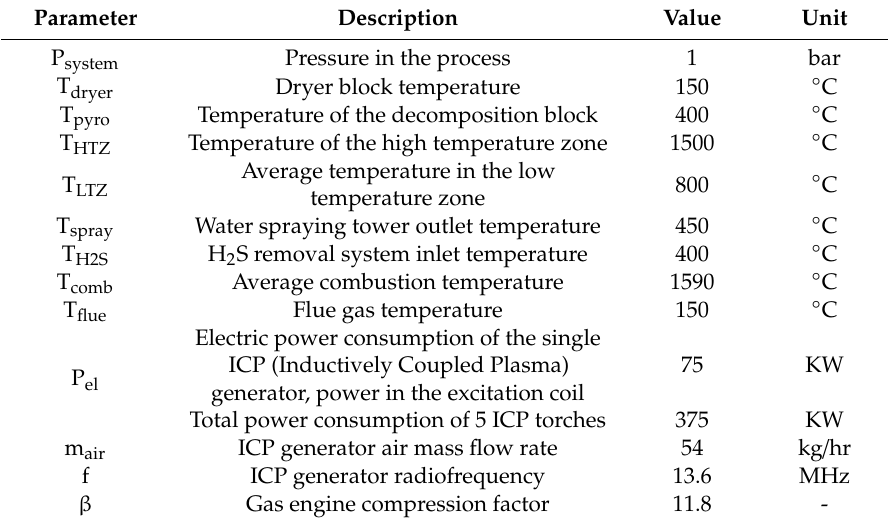
Table 4. Fixed process